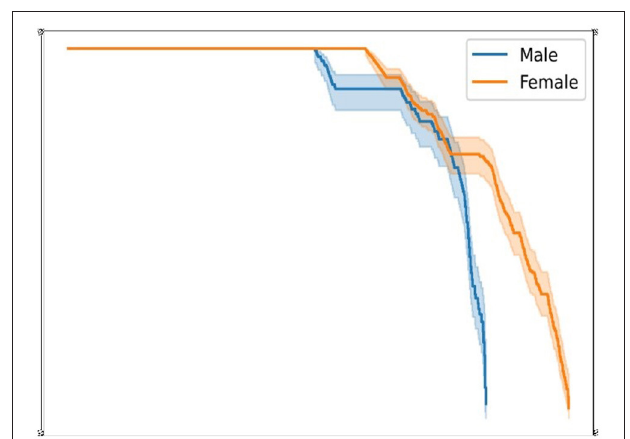
FIGURE 4 | Age_Cox